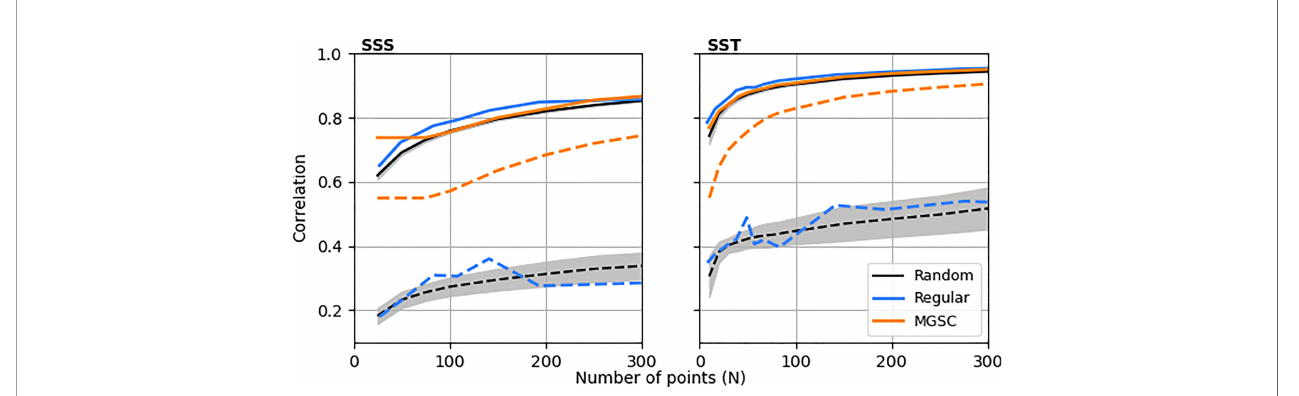
FIGURE 3 | Mean and minimum correlations that can be achieved throughout the domain using three different observation placement methods: set cover algorithm, regular gridding and an ensemble of random placements. Solid lines show the mean correlations for each placement method and dashed lines show the minimum. For the random placements, lines show the ensemble mean and the shaded areas show 1 standard deviation either side of